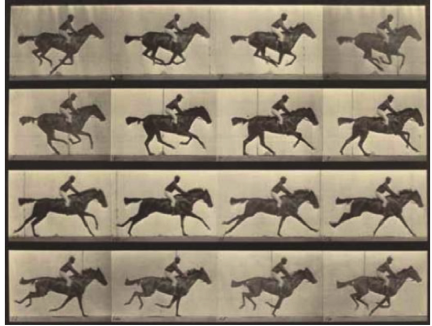
Figure 3: The Horse in Motion (1872) by Eadweard Muybridge [4].